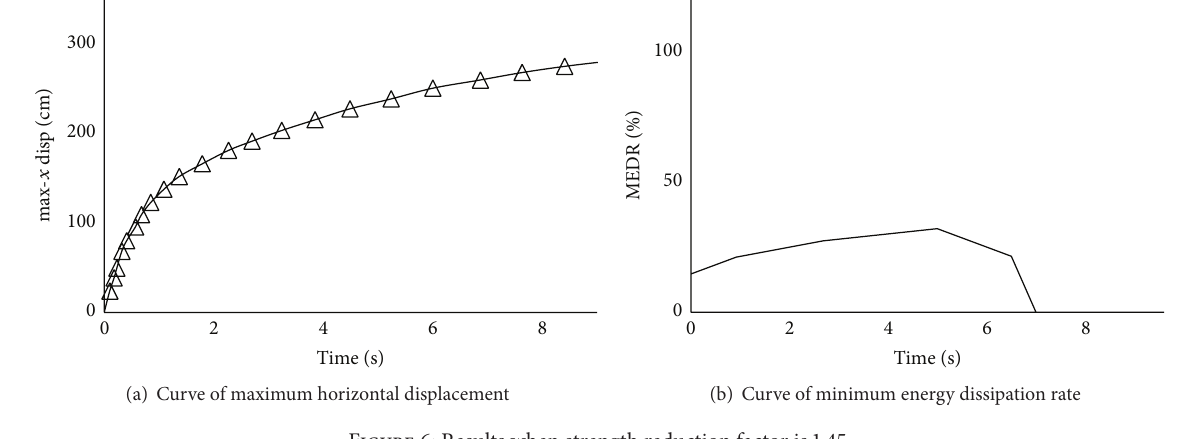
Figure 6: Results when strength reduction factor is 1.45.